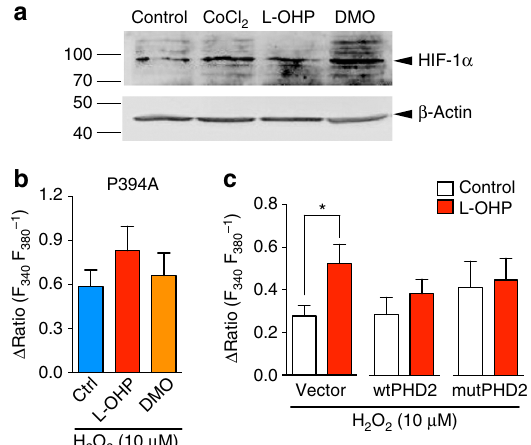
Figure 6 | L-OHP and DMO elicit hTRPA1 sensitization via PHD inhibition. ( a ) Representative western blots of whole-cell lysates of HEK293 cells pretreated with vehicle, 100 m M CoCl 2 , 100 m M L-OHP or 30 m M DMO for 24h. CoCl 2 (100 m M) was used as a positive control. ( b , c ) Statistical analysis of the H 2 O 2 -evoked [Ca 2 þ ] i increase in hTRPA1-P394A- expressing cells ( b , n ¼ 5–6) or hTRPA1-WT-expressing cells cotransfected with vector, hPHD2 (wtPHD2) or mutant hPHD2 (mutPHD2) ( c , n ¼ 5–7) pretreated with or without L-OHP (100 m M) or DMO (30 m M). * P o 0.05; unpaired t -test. All data are expressed as mean ±